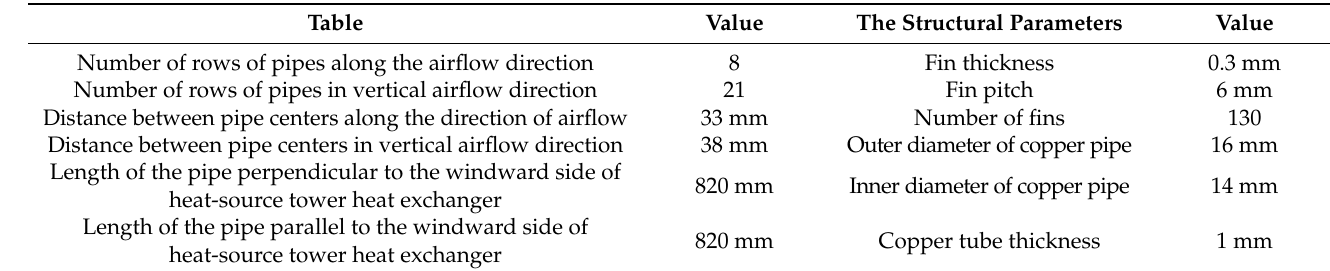
Table 3. The measurement parameters of test instruments.